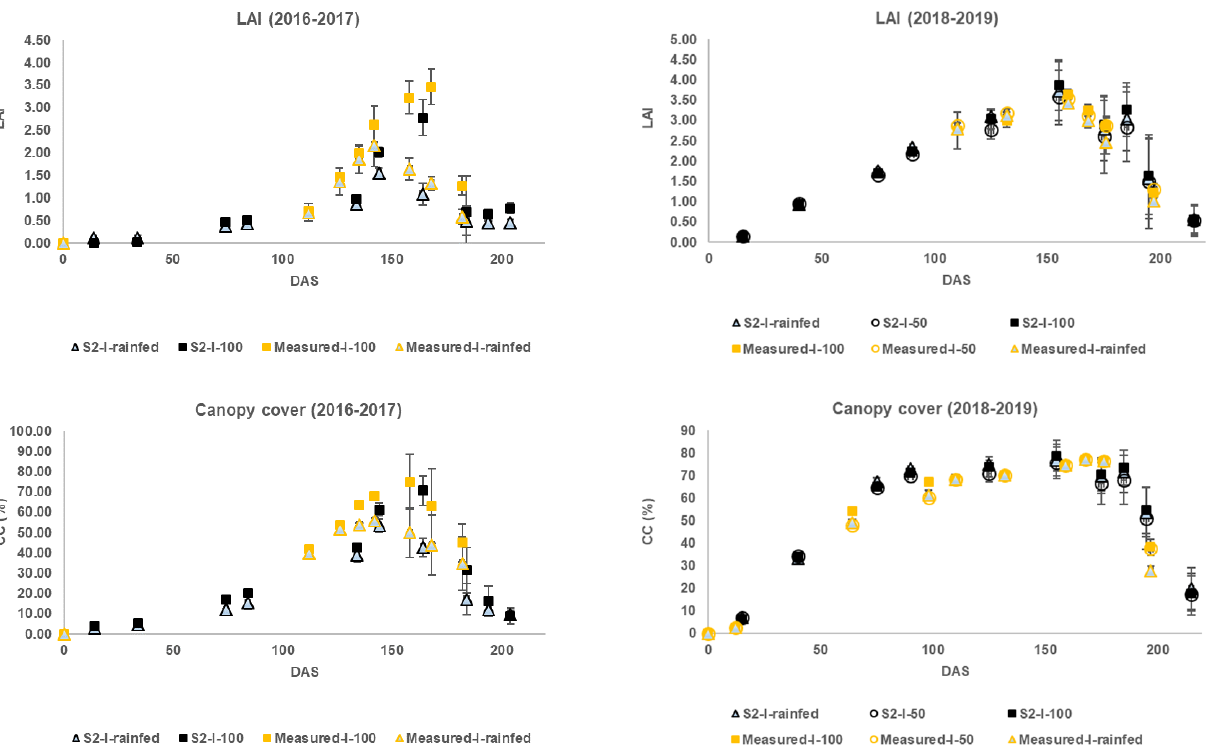
Figure 2. The seasonal trends of LAI and canopy cover (FVC) as compared to the ground measurements during the seasons 2016–2017 and 2018–2019.